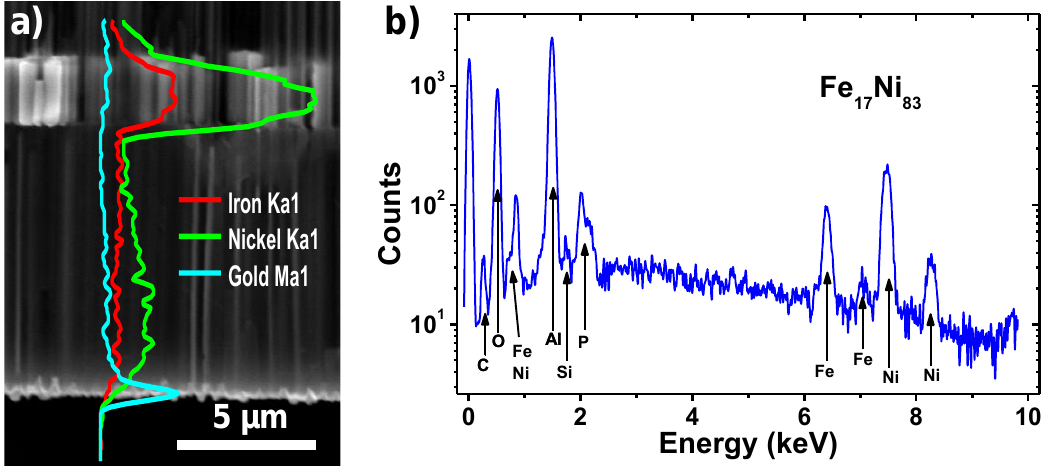
Figure 3. ( a ) EDX compositional profile line-scan performed on a cross-section SEM image of FeNi diameter modulated nanowires; and ( b ) the EDX spectrum indicating the elemental composition of the WM2 sample shown in ( a ).